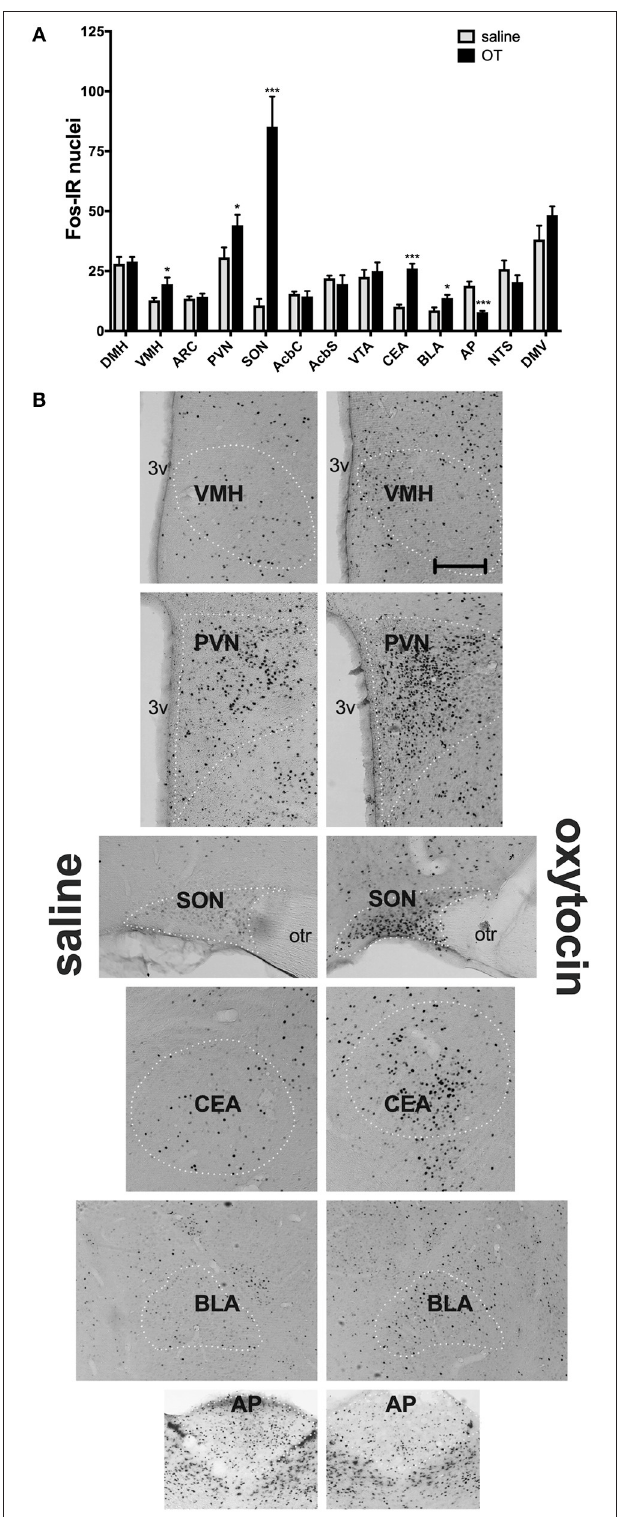
FIGURE 4 | c-Fos immunoreactivity in feeding-related brain sites following i.p. administration of saline or OT (1 mg/kg) in animals that had no access to food